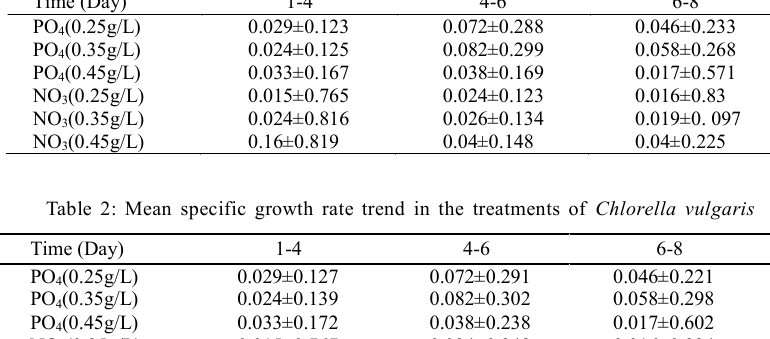
Table 1: Mean specific growth rate trend observed in the treatments of Spirulina platensis Time (Day) 1-4 4-6 6-8 PO 4 (0.25g/L) 0.029±0.123